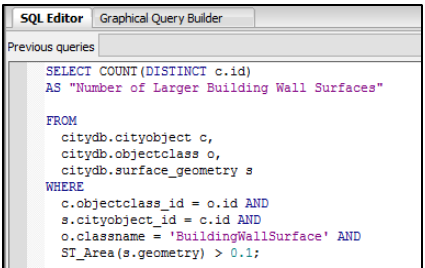
Figure 12: Example of spatial query in